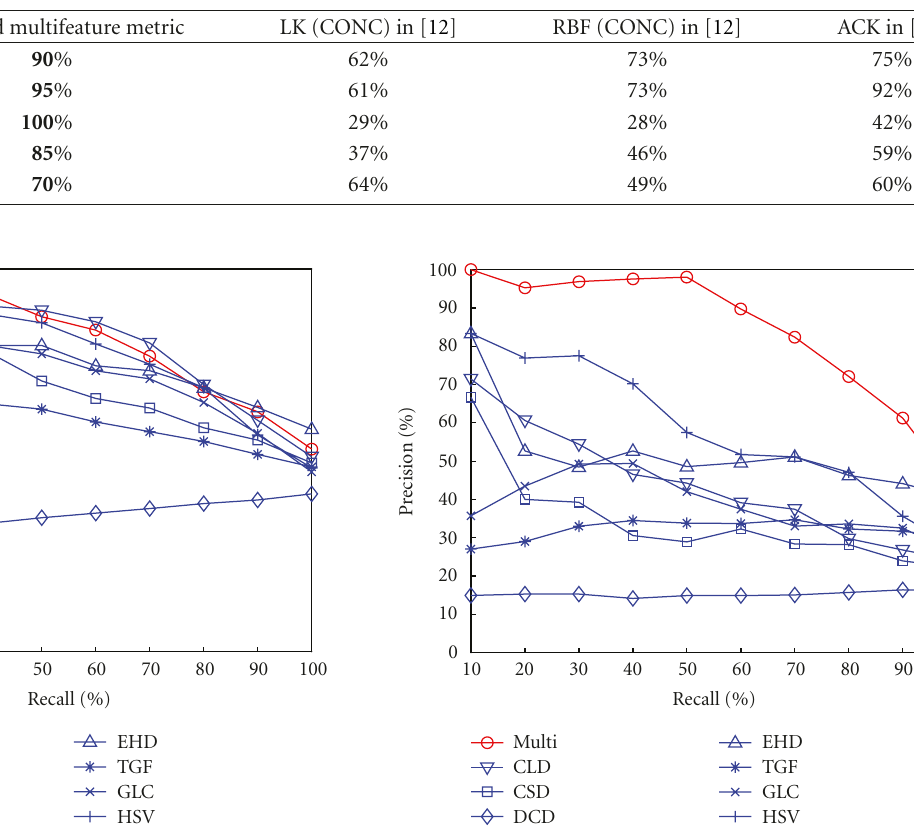
Table 4: Our results comparing with precision values at the second iteration, presented in [12].